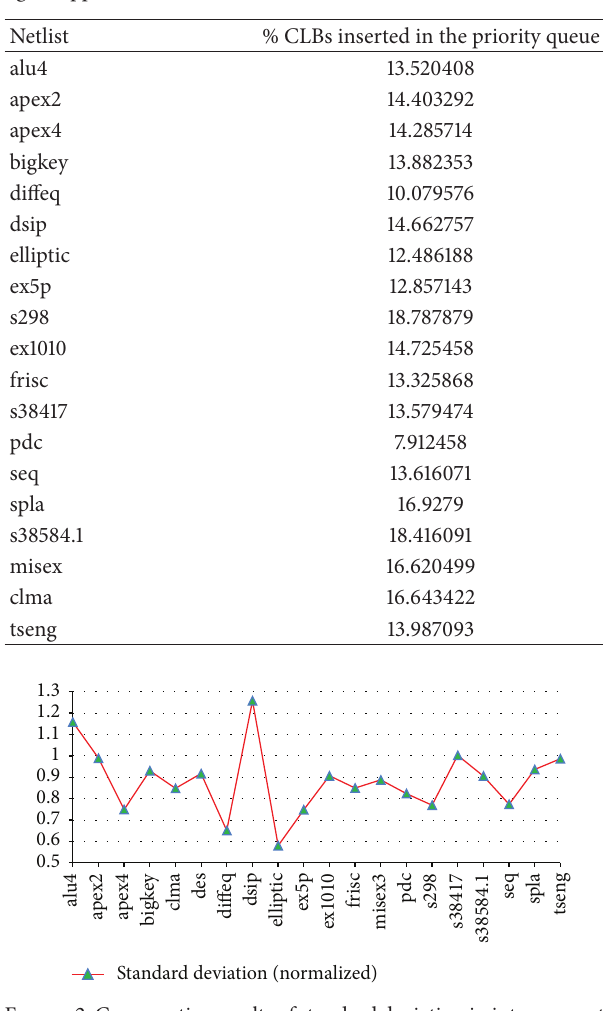
Table 3: Percentage of CLBs inserted in the priority queue for average approach.